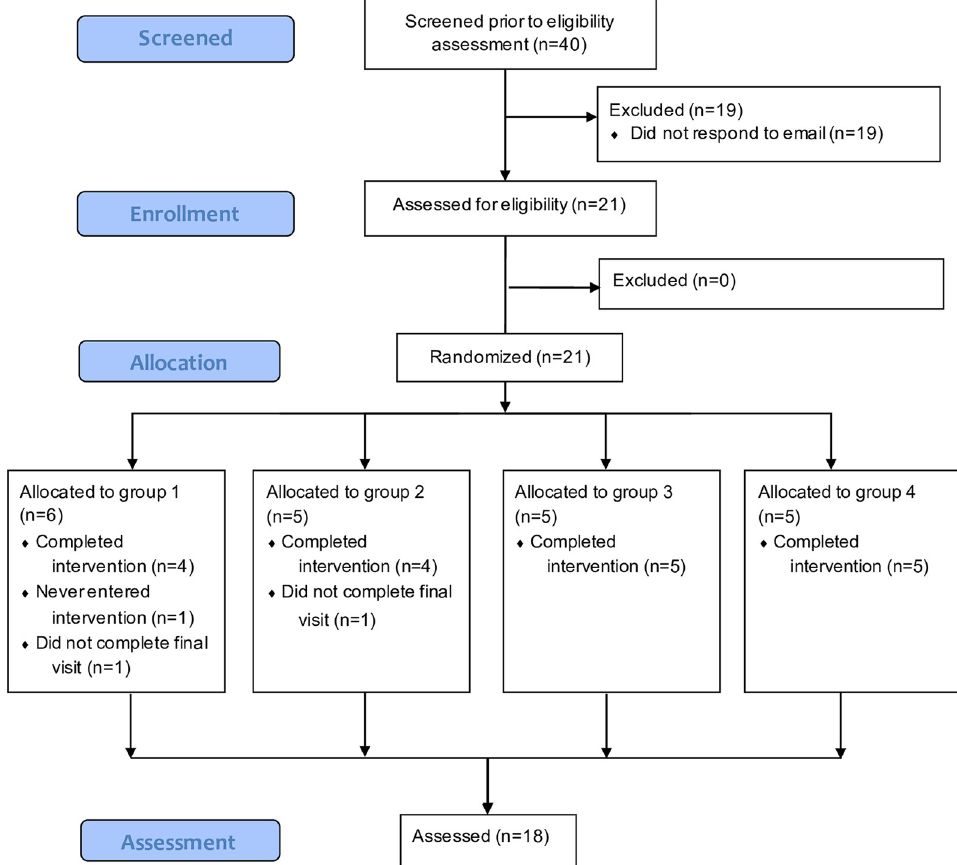
Fig 1. CONSORT Flow Diagram. Flow diagram of patient recruitment and dropouts. Study design: Multiple-baseline design across groups. The four groups introduced the treatment staggered in time to separate treatment effects from potential time effects and therefore enhance internal validity. Baseline length for each group was randomly selected following the Koehler-Levin procedure and patients were randomly allocated to groups. Intervention phase was the same length for all groups. Before baseline and after intervention phase, clinical questionnaires were